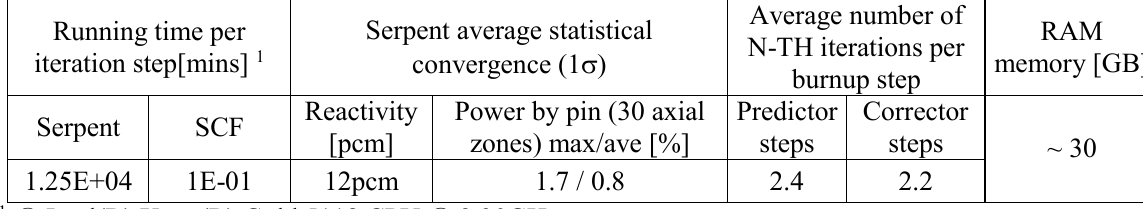
Table III: Average running aspects of the proposed coupled